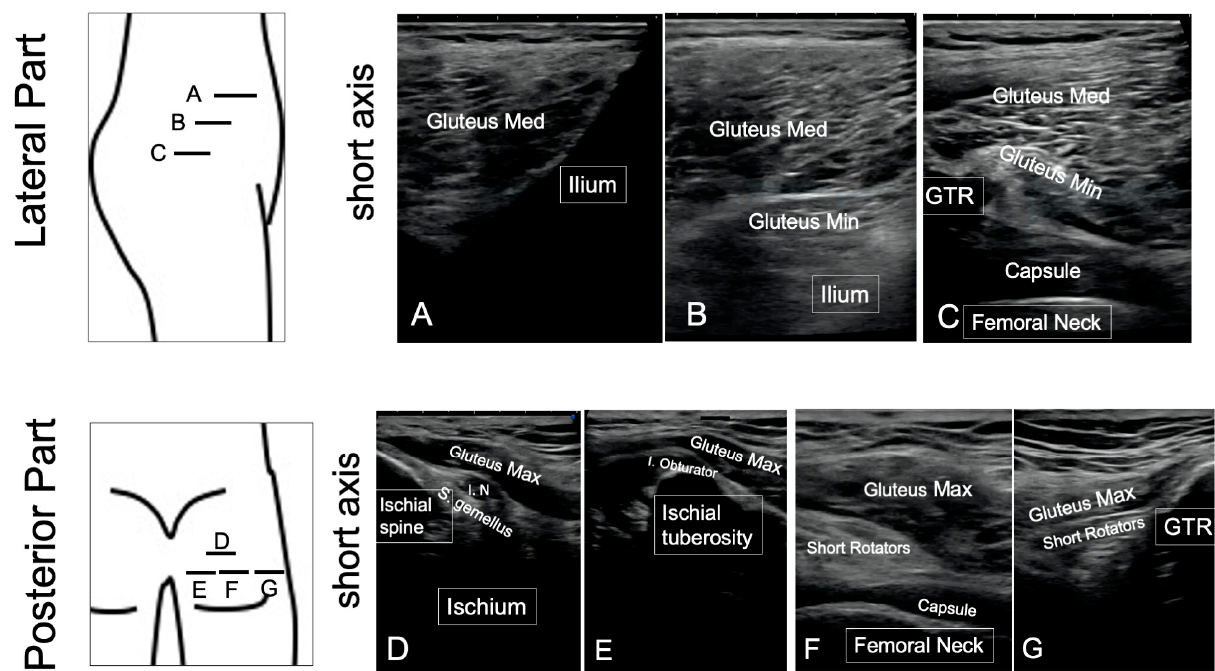
Figure 2. Representative sonography images of the lateral and posterior part in hip resurfacing patients. Periprosthetic hip soft tissues were assessed using short axial images in the lateral ( A – C ) and posterior part ( D – G ). In the lateral assessments, the gluteus medius and minimus were observed using ASIS and GTR as bony landmarks ( A – C ). In the posterior assessment, the gluteus maximus, short rotators, and capsule were observed using the ischial tuberosity and GTR as bony landmarks ( D – G ). Gluteus Med, gluteus medius; Gluteus Min, gluteus minimus; ASIS, anterior superior iliac supine; GTR, greater trochanteric; I.N., ischial nerve; S. gemellus, superior gemellus muscle; I. Obturator, internal obturator muscle.